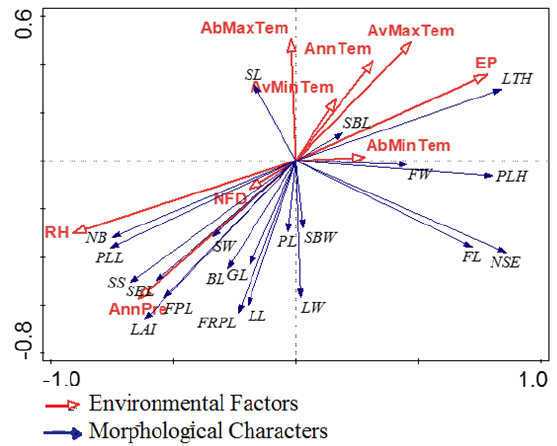
Fig. 5 . Redundancy analysis plot showing an association among environmental variables in climate and morphological attributes of C. spinosa concerning the first two ordination